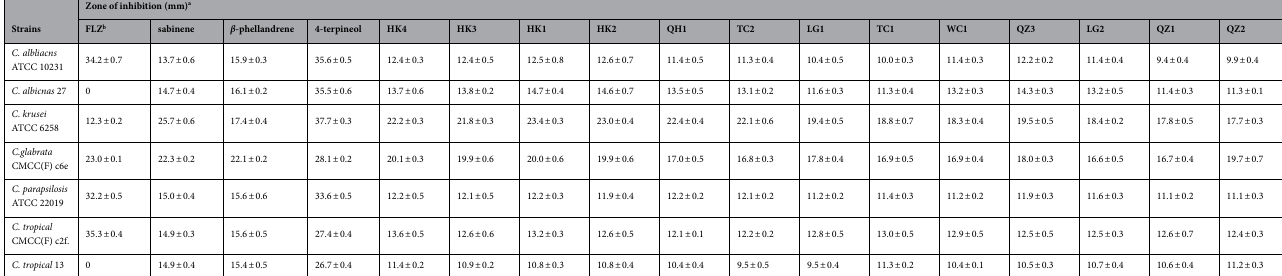
Table 4. Antifungal activity of EOs of C. lansium seeds and three pure chemicals. a Values represent the means of three independent replicates ± SD; concentrations: EOs:10 μL/disc; b FLZ: Fluconazole, 25